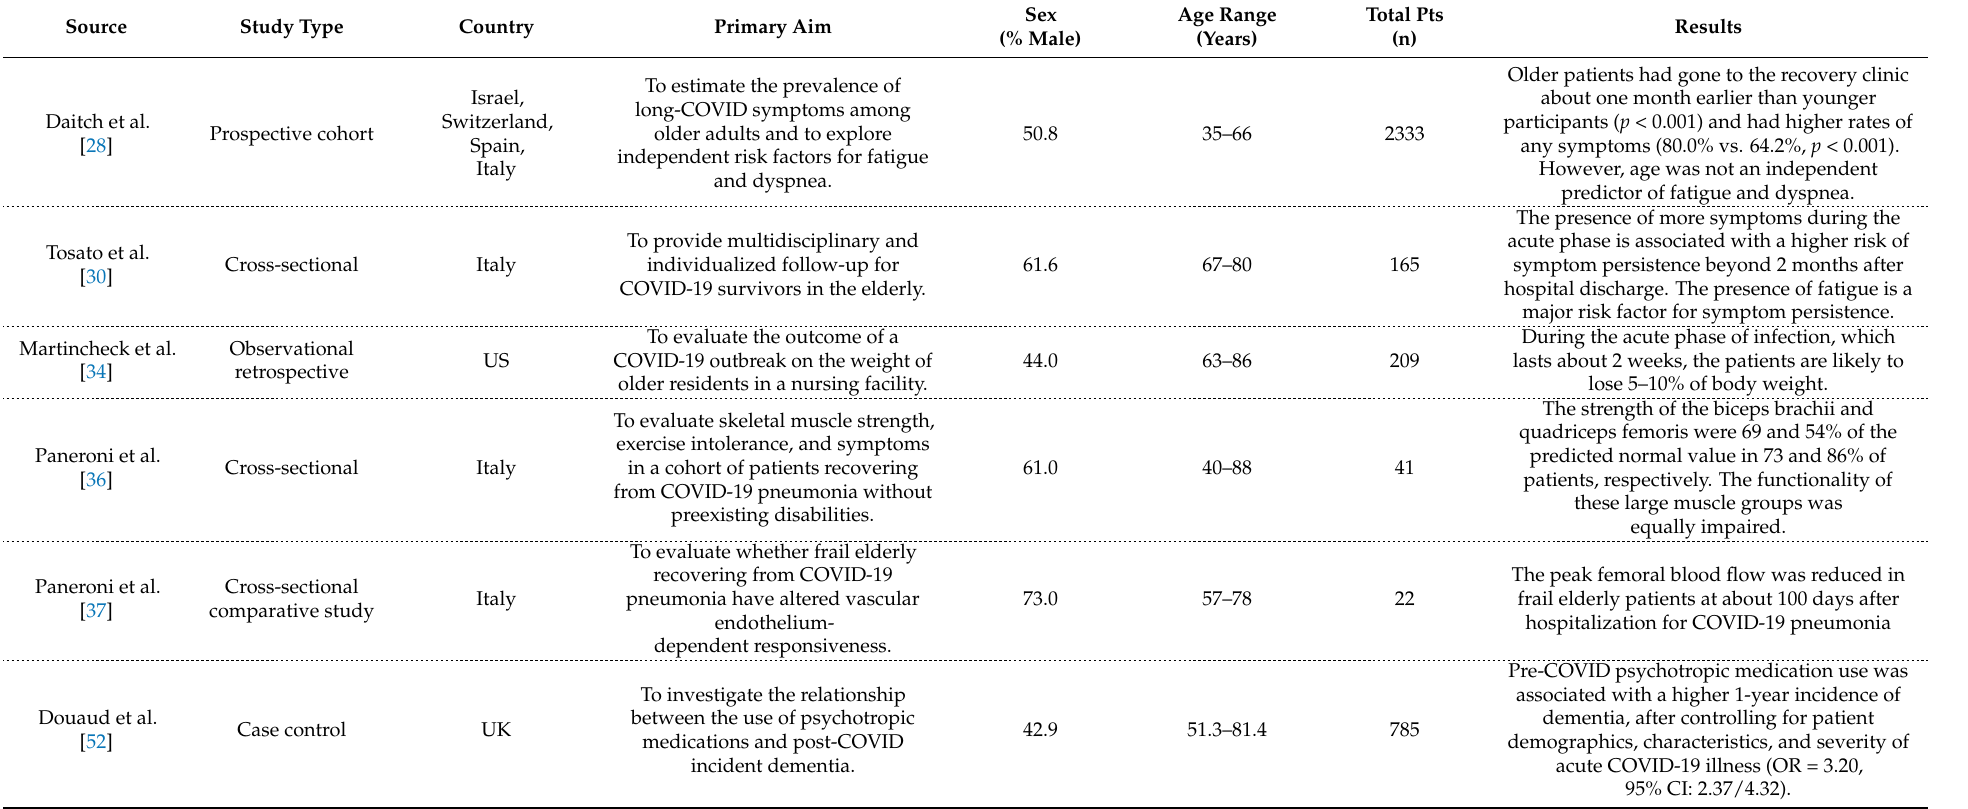
Table 1. Studies of long COVID in the